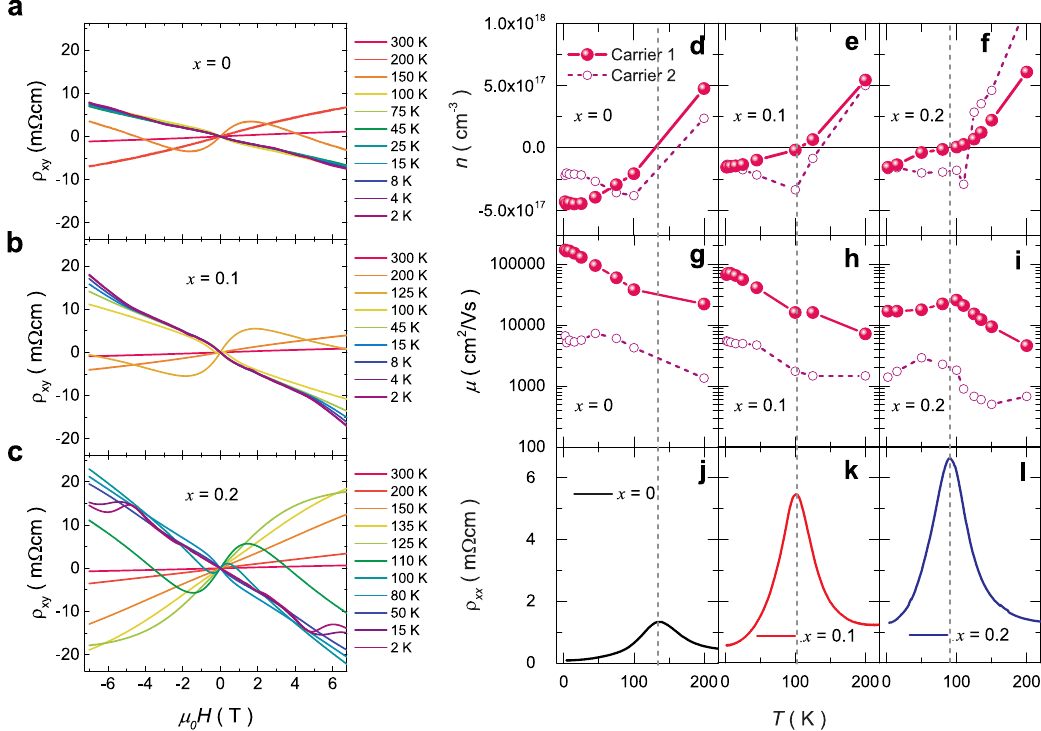
Fig. 2 Transport properties of Ti x Zr 1- x Te 5 . a – c Hall resistivity as a function of a magnetic fi eld. d – f Carrier density and g – i carrier mobility as a function of temperature evaluated by the two-carrier model. The error bars of d – i are the standard errors of the two band fi t, which are smaller than the size of the data symbols. j – l Electrical resistivity as a function of temperature. The gray lines are drawn as a guide for T p , the temperature showing the resistivity peak.